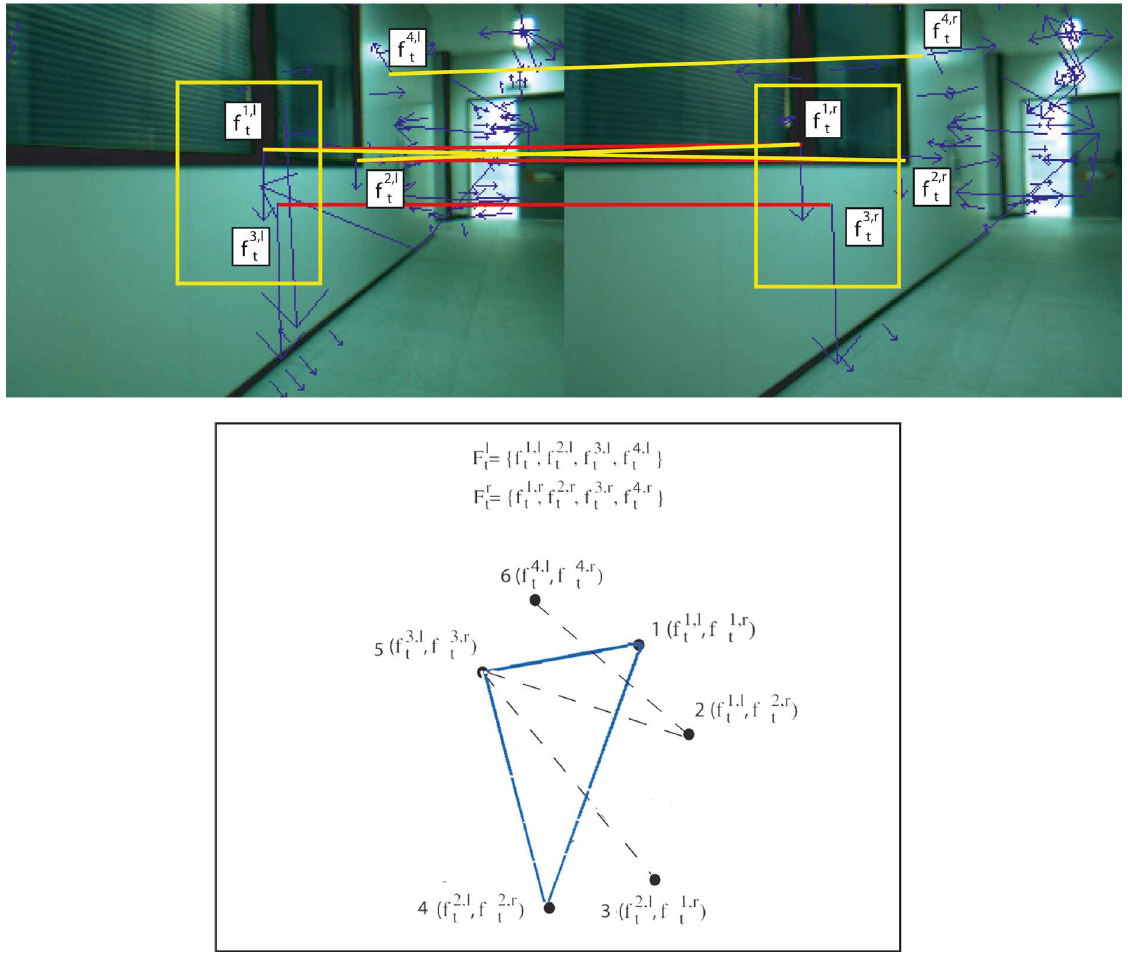
, f 2 ,l , f 3 ,l → f 1 ,r → f 2 ,r → f 3 ,r t t t t t t